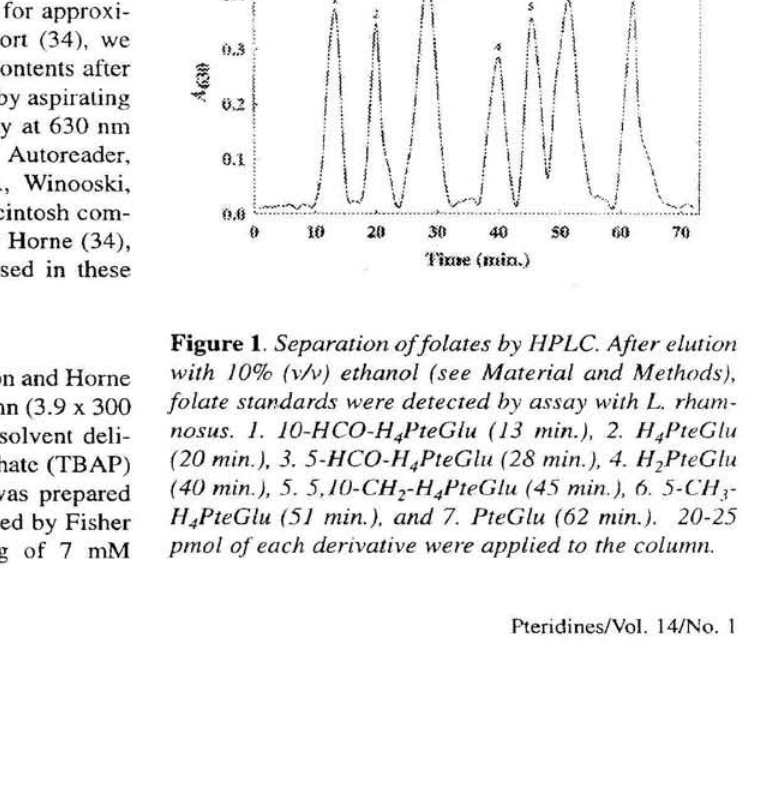
pmol of each derivative were applied to the